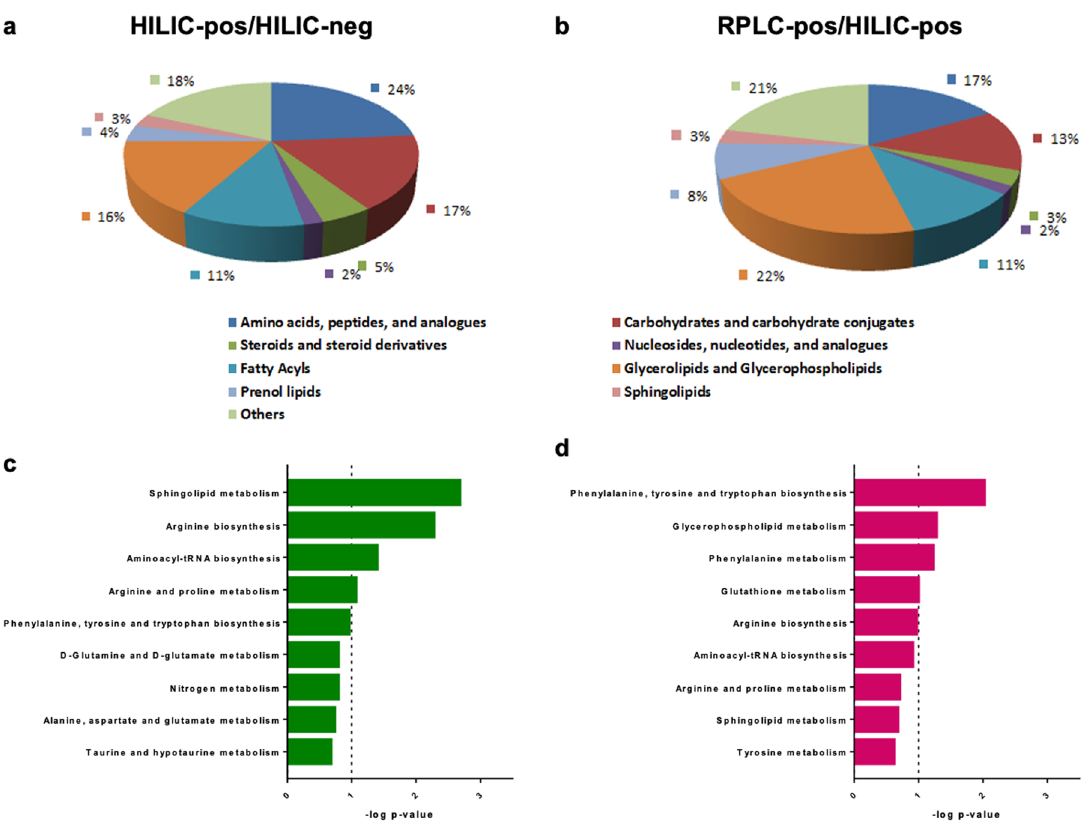
Fig. 7 Biochemical classi fi cation and pathway analysis of metabolites differentially regulated in SM and PM neural precursors. a , b Metabolites signi fi cantly different between PM and SM were classi fi ed according to their biochemical properties and c , d pathway analysis was performed. The top 9 signi fi cant response pathways are shown for each data set with a total of 8 pathways being signi fi cantly different between SM and PM ( p ≤ 0.1 is indicated by the dashed